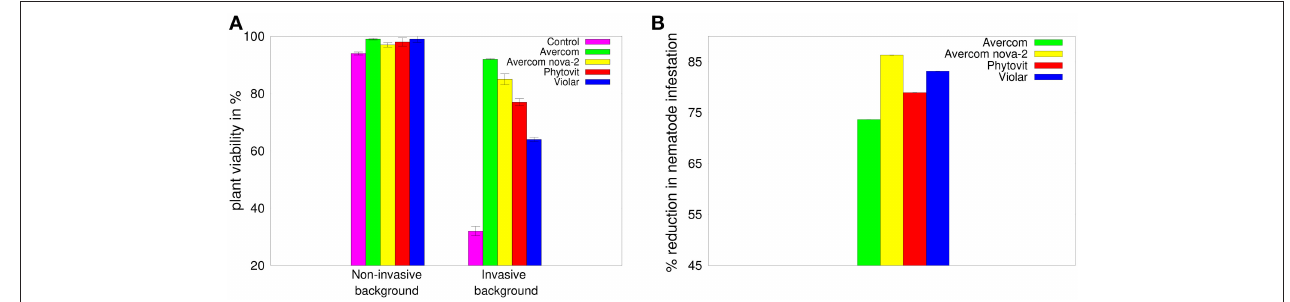
FIGURE 2 | (A) Effects of biostimulants on viability of plants grown on non-invasive or invasive background in perlite-filled cuvettes from seeds treated in planta by biostimulants, as compared to a viability of control plants grown in perlite-filled cuvettes without biostimulants. (B) Reduction in infestation with H. avenae larvae of plants grown in perlite-filled cuvettes from seeds treated in planta by biostimulants, as compared to control plants grown in perlite-filled cuvettes in a nematode-infested background without biostimulants. The error bars in plot (B) are not visible, since they are almost 3 orders of magnitude smaller than the reported